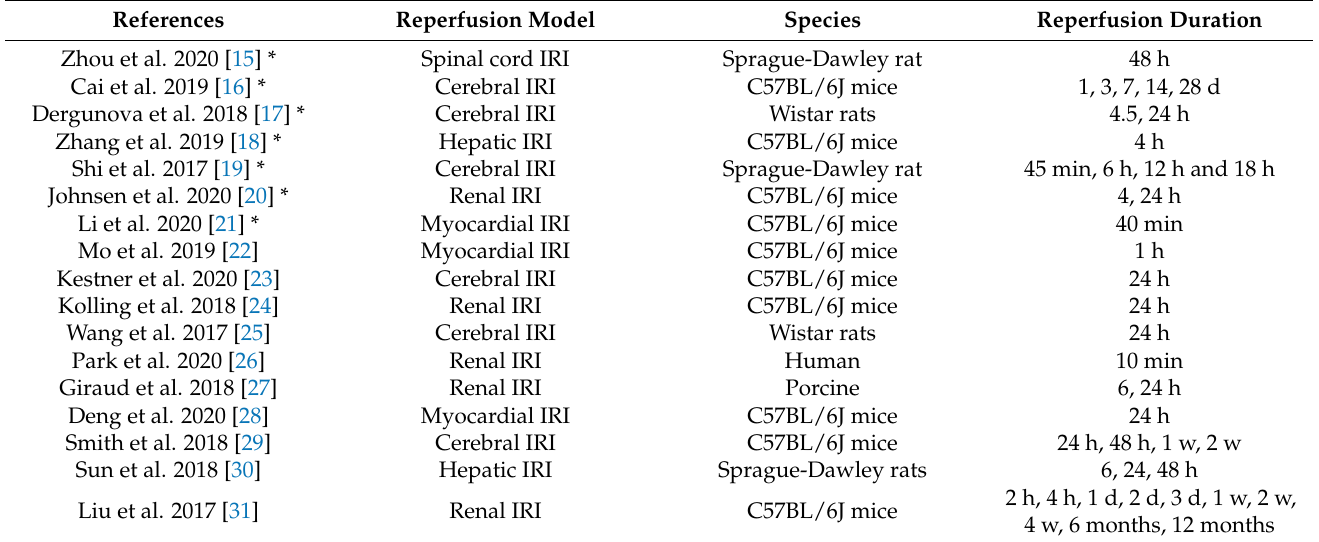
Table 1. Summary of studied articles in this